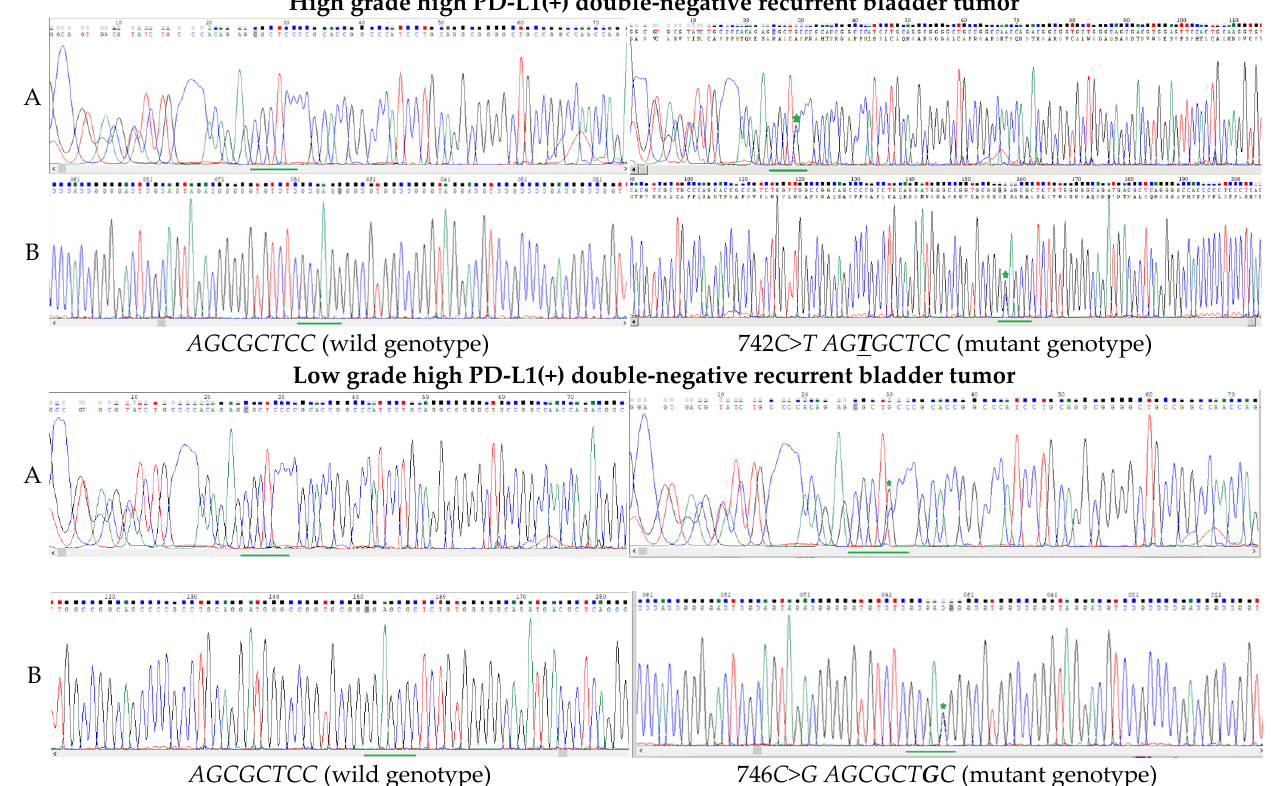
Figure A2. Hotspot mutations in codons 248 and 249 of FGFR3 7th exon in tumor cells of high- and low-grade double- negative NMIBC: ( A ) forward primer; ( B ) reverse primer; AG C GCT C C nucleotide sequence represents wild allele genotype; substitutions C->T in position 3 or C->G in position 7 referred to mutant FGFR3 genotypes .